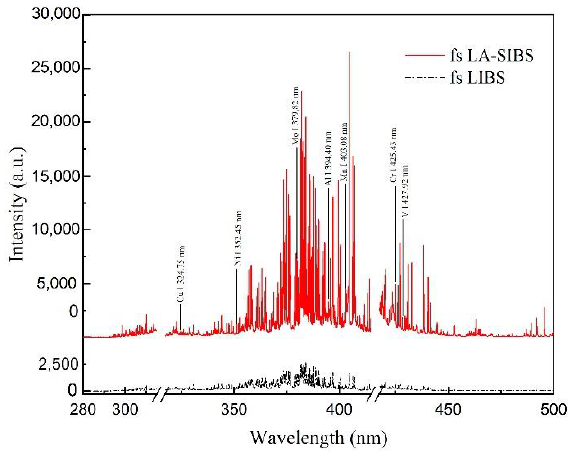
Figure 2. Plasma emission spectra recorded in fs LA-SIBS and fs LIBS. The integral time of CCD was 2 ms, and each spectrum was averaged for 500 repeated measurements. 2 ms, and each spectrum was averaged for 500 repeated